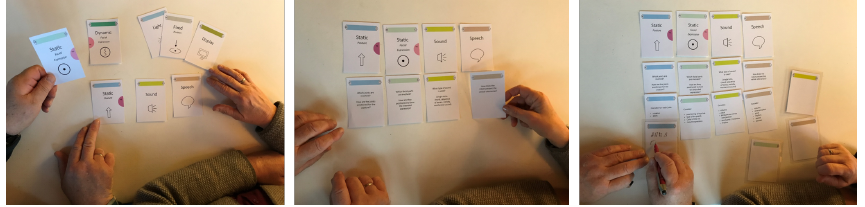
Figure 5. Participants designing multimodal behavioral expressions for the Pepper robot with the Modality Card Deck, following the three phases (from left to right): Select your preferred communication modality , understand the design challenge , and specify the communication modality